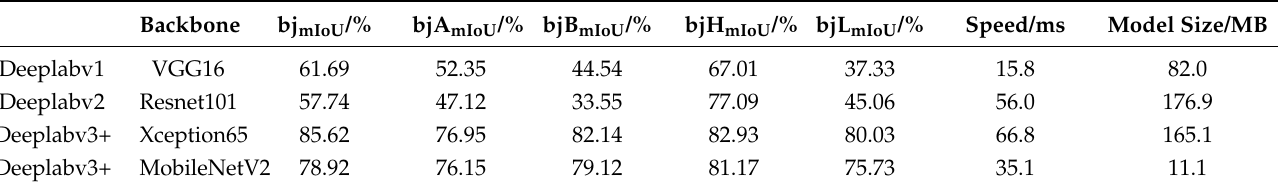
Table 4. A comparison of segmentation